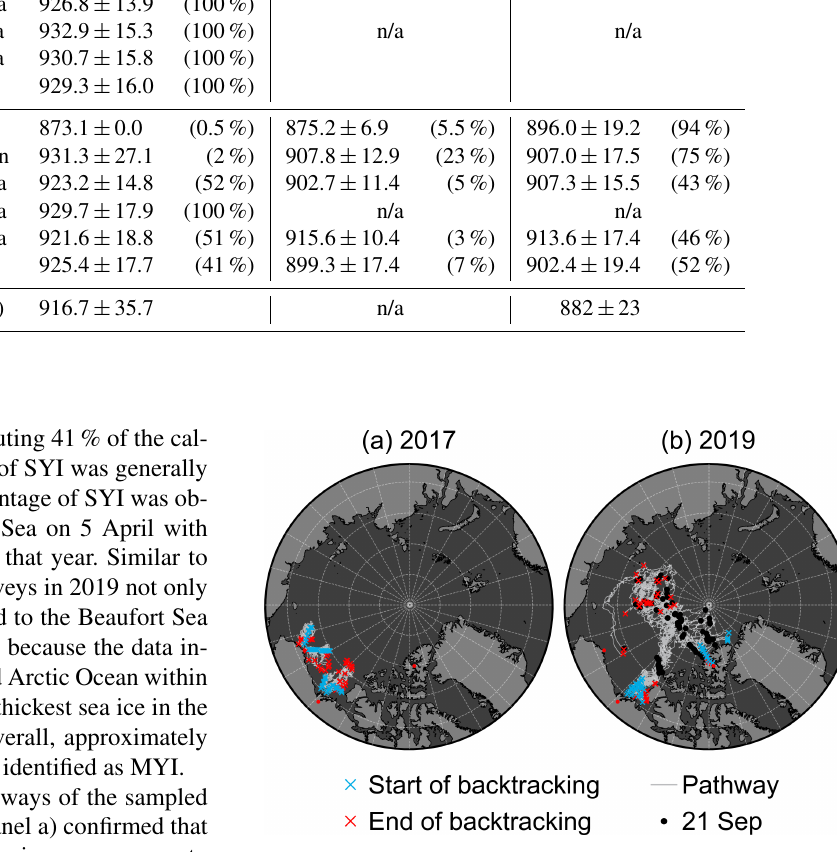
Figure 4. Pathways of the sea ice sampled (a) in 2017 and (b) in 2019. Black dots (visible only in panel b ) represent the position of the backtracked sea ice on 21 September in the preceding years before sampling, when ice parcels are considered to have survived the